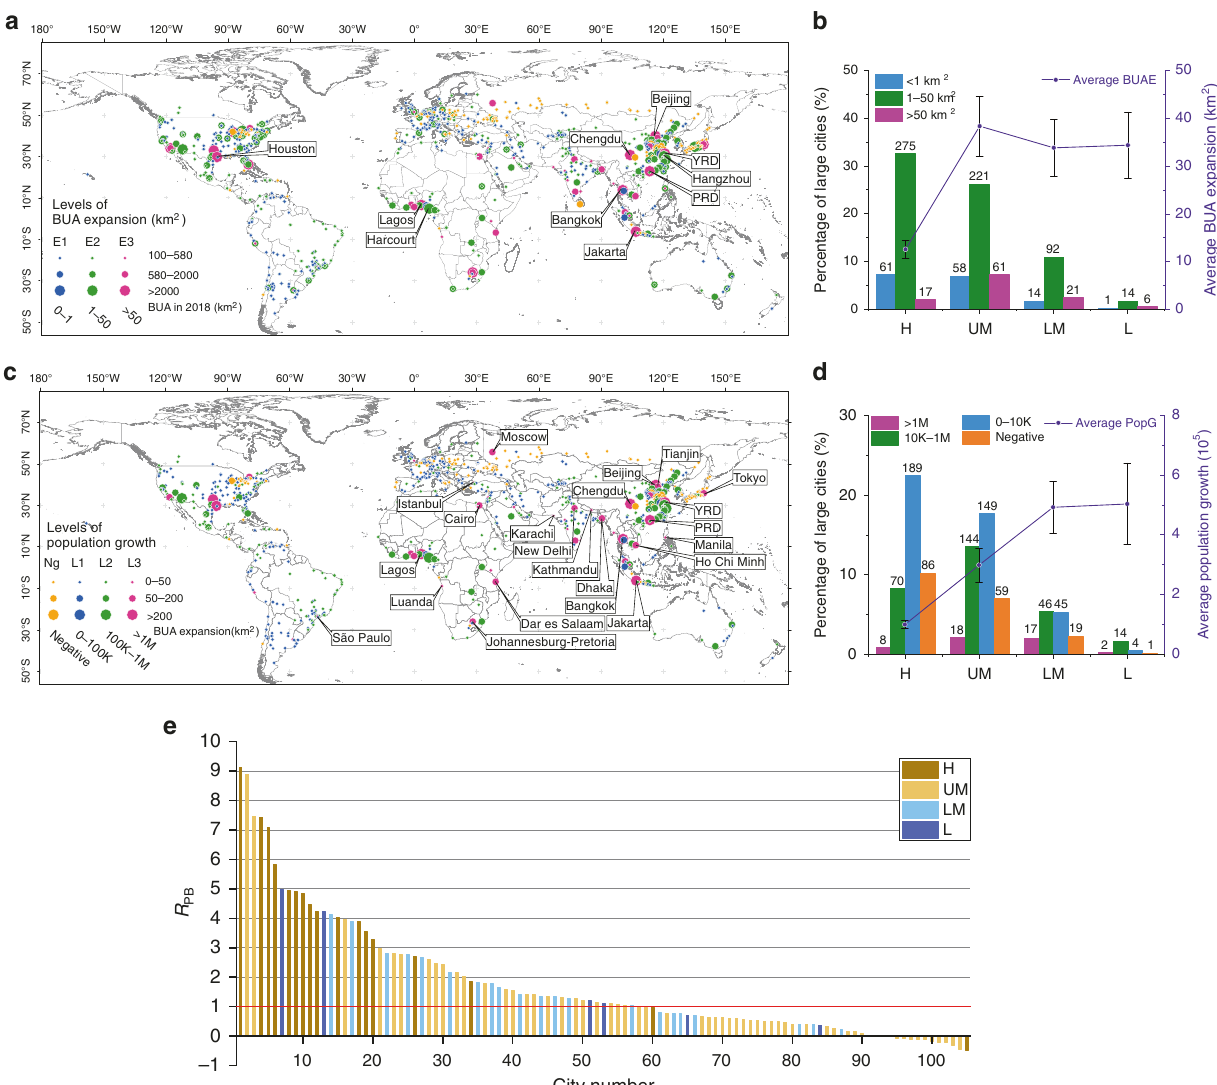
Fig. 1 Distribution of large cities with the built-up area (BUA) expansion and population growth. a Distribution of the 841 large cities at different levels of the BUA expansion (BUAE) from 2001 to 2018. E1: 0 ≤ BUAE ≤ 1 km 2 , blue points; E2: 1 km 2 < BUAE ≤ 50 km 2 , green points; E3: BUAE > 50 km 2 , magenta points. The top 10 cities with BUAE are labeled with their names. YRD Yangtze River Delta, PRD Pearl River Delta. b Bars are the percentages of the total 841 large cities for the large cities at the different levels of BUAE and 4 economic levels. Purple lines are the average BUAE values of the large cities at different economic levels. c Distribution of 841 large cities at different levels of population growth (PopG). Ng: negative population growth, orange points; L1: 0 < PopG ≤ 100K, blue points; L2: 100K < PopG ≤ 1M, green points; L3: PopG > 1M, magenta points. The 22 large cities with a PopG of more than 2 million are labeled with their names. d Bars are the percentages of all the large cities for PopG at four different economic levels. Purple lines are the values of average population growth of large cities at different economic levels. All large cities are classi fi ed according to the World Bank ’ s estimates of 2018 gross national income (GNI) per capita, H high income, UM upper middle income, LM lower middle income, and L low income; see Methods for details. e The ratio ( R PB ) of the urban population growth rate to the BUAE rate for the 105 large cities with BUAE of over 50 km 2 from 2001 to 2018 (magenta points in ( a )). For each city, the urban population growth rate was calculated using the data for the period from 2000 to 2015. In ( b , d ), the error bars show SEM (standard error of the mean) for each economic level.